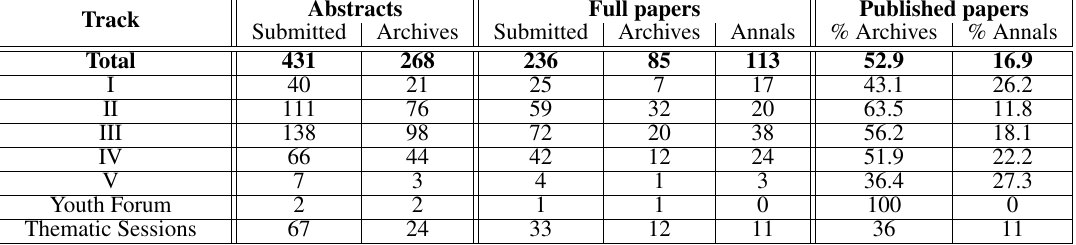
Table 2. Detailed statistics for each